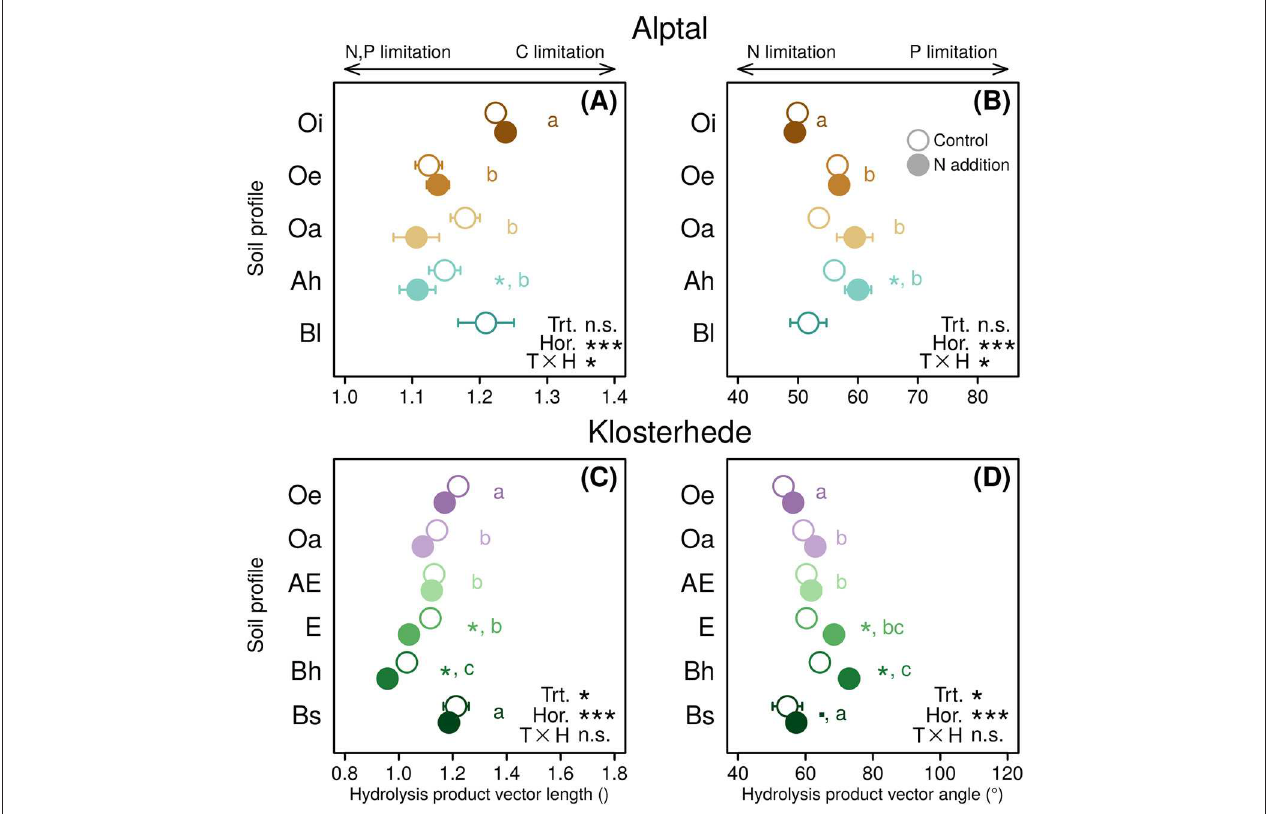
FIGURE 7 | Enzyme-based vector lengths (A,C) and vector angles (B,D) in response to N addition along the topsoil profile (0–30cm) at Alptal (A,B) and Klosterhede (C,D) . Increasing hydrolysis product vector lengths indicate strogner relative C vs. nutrient limitation (A,C) . Increasing hydrolysis product vector angles indicate stronger relative N vs. P limitation (B,D) . Post-hoc differences between control and N addition treatment within soil horizon are indicated by symbols next to circle pairs ( (cid:4) P < 0.1; * P < 0.05; ** P < 0.01; *** P < 0.001). Lower-case letters indicate post-hoc differences between soil horizons across treatments. Means with no letter in common are significantly different (Tukey’s HSD, α =